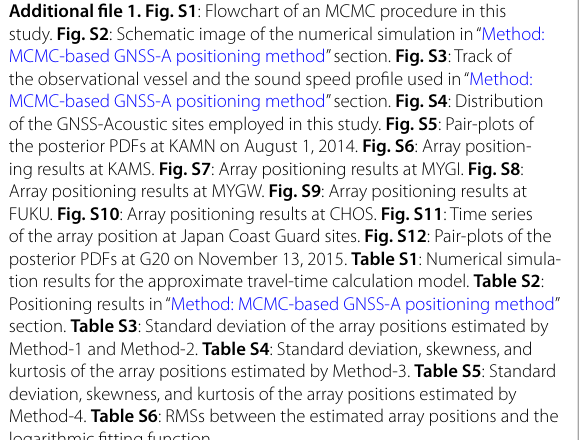
section. Table S3 : Standard deviation of the array positions estimated by Method-1 and Method-2. Table S4 : Standard deviation, skewness, and kurtosis of the array positions estimated by Method-3. Table S5 : Standard deviation, skewness, and kurtosis of the array positions estimated by Method-4. Table S6 : RMSs between the estimated array positions and the logarithmic fitting